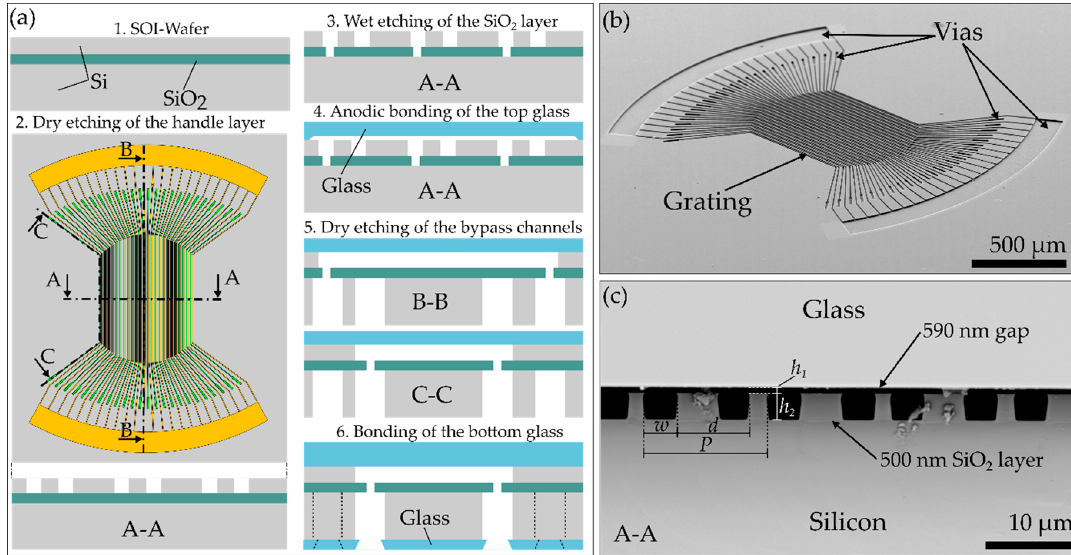
Figure 3. ( a ) Schematic of the fabrication steps for the nanofluidic grating chip with a top view for the first step and cross-sectional views for the following steps. ( b ) Tilted SEM top view of the optical grating after the first 4 µm deep etching into the silicon device layer prior to bonding. ( c ) SEM cross-sectional view of the nanogap area after anodic bonding of the top glass with gap width h 1 , channel height h 2 , channel width w , displacement d and period P .